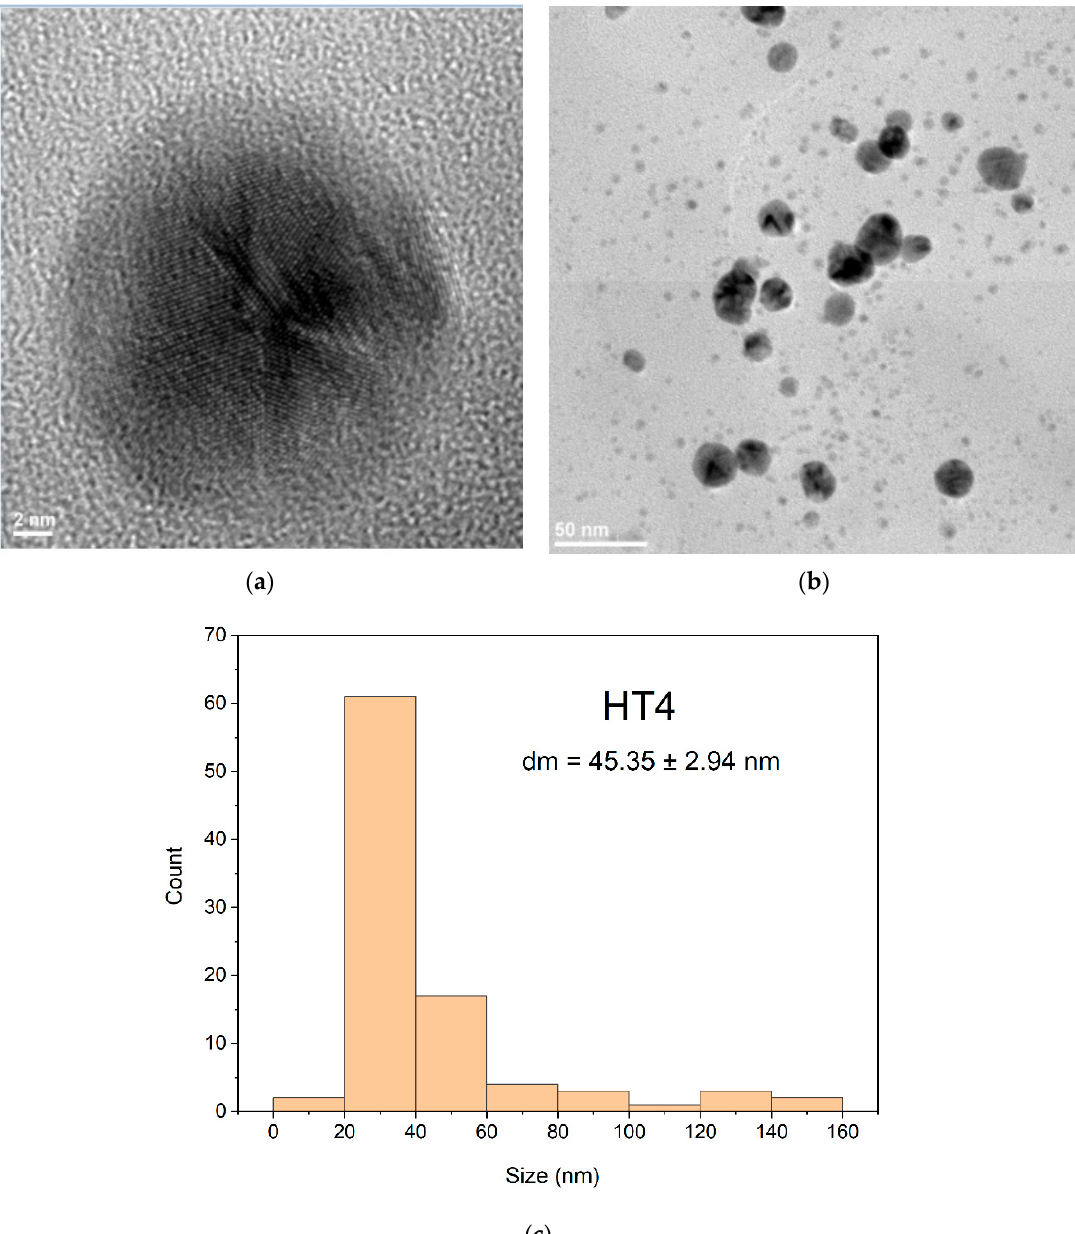
Figure 13. TEM images for the AgNPs sample HT4 at two different magnifications ( a )—high magnification and ( b )—low magnification) and the appropriate histogram ( c ) .